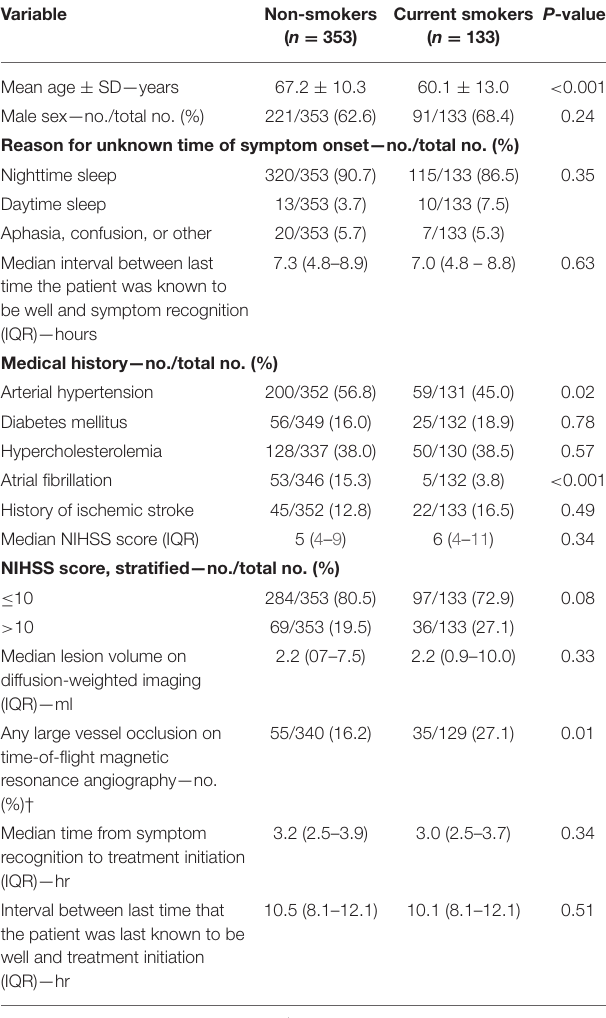
TABLE 1 | Demographic and clinical characteristics at baseline according to smoking